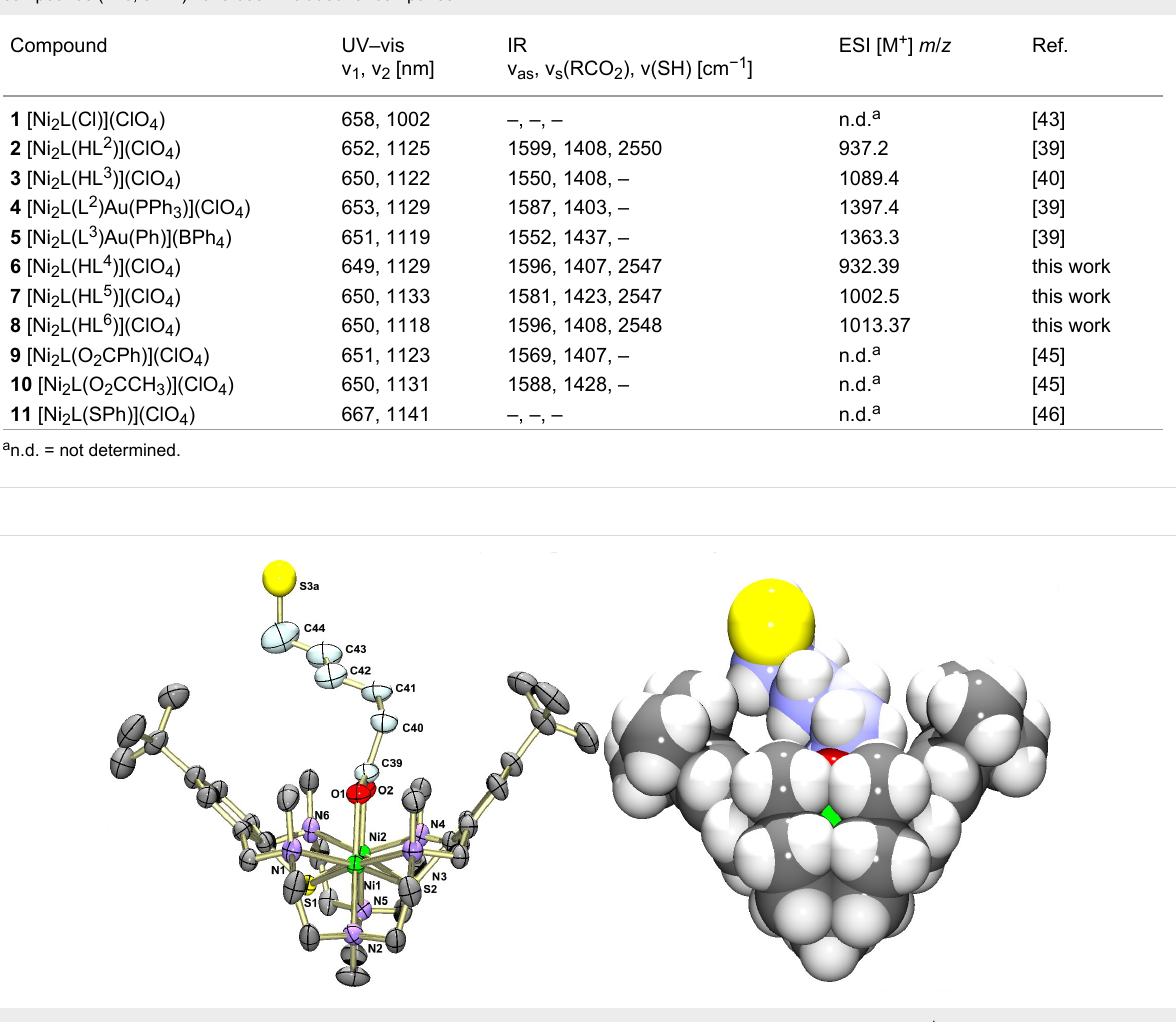
the [Ni 2 L(HL 4 )] + cation in 6 , with the mercaptohexanoate unit bridging the two Ni(II) ions in a symmetrical fashion as ex- pected from the spectroscopic data. The [Ni 2 L] 2+ fragment adopts a cleft-like structure as observed in other carboxylato- bridged complexes supported by L [45]. In contrast to other ω -mercapto-alkanethiols, which adopt an extended zig-zag